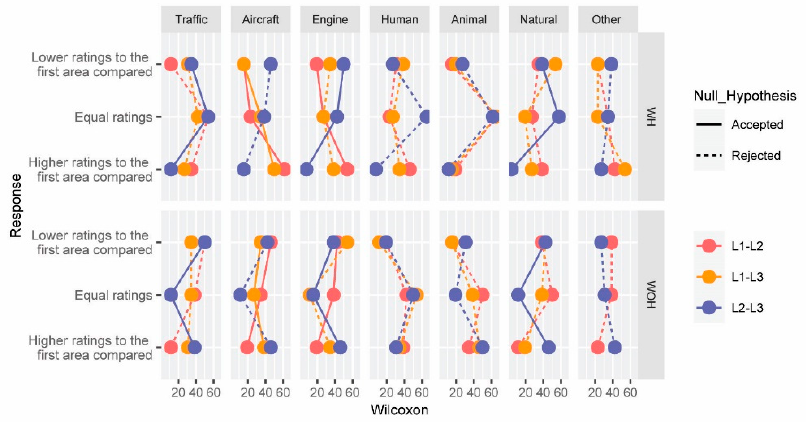
Figure 5. Wilcoxon signed-rank test results of the appraisals about the sound sources (sounds of road traffic, aircraft, engine, human, animal, natural, and others) at paired locations L1–L2 (red), L1–L3 (green), and L2–L3 (blue), for the conditions with and without the helicopter noise, independently considered. Significant (continuous line) and non-significant differences (dashed line) between paired variables are also represented.